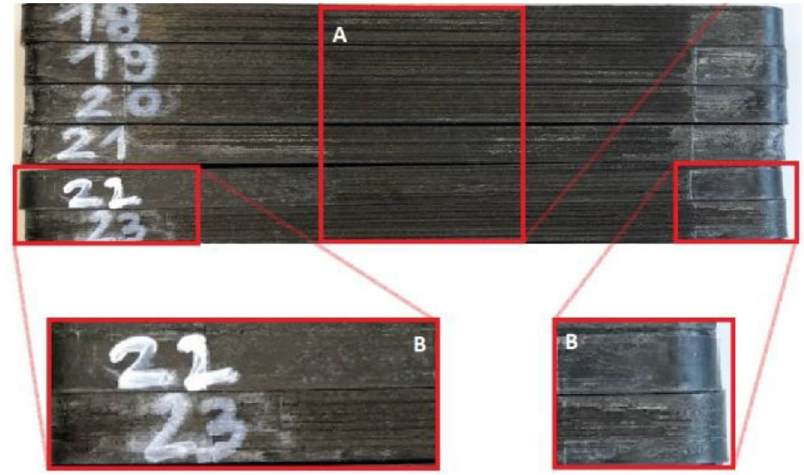
Figure A2. Tensile test specimens of 3D-printed CFRP straps before testing, details show curvature areas with partially poor impregnation.